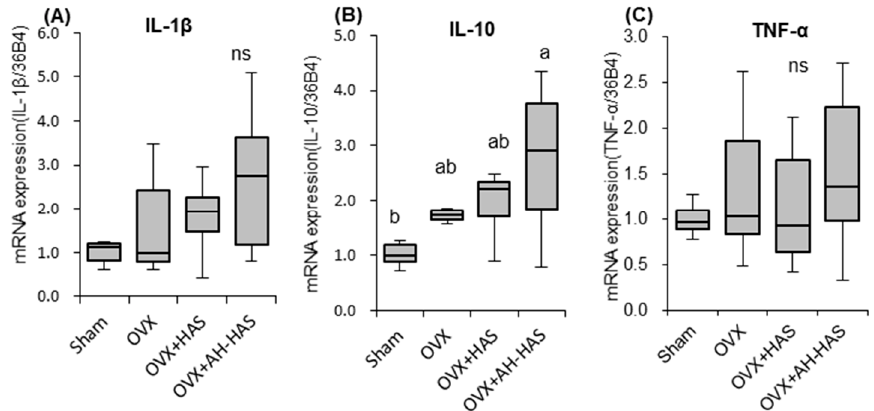
Figure 2. mRNA expression of IL-1 β ( A ), IL-10 ( B ) and TNF- α ( C ) in the colons of mice. mRNA of the colon was obtained from sham mice and OVX mice fed a control diet, 20% high-amylose corn starch (HAS)-supplemented diet (OVX + HAS), or an 20% acid-hydrolysed high-amylose corn starch (AH-HAS)-supplemented diet (OVX + AH-HAS) for 42 days. mRNA expression was determined by qRT-PCR. The ordinate axis indicates the relative amount of mRNA compared with that in sham mice. Gene expression was expressed as the fold-change relative to sham mice and normalised with 36B4. Values are the mean ± SEM ( n = 8). mRNA expression in the colon was assessed using one-way analysis of variance (ANOVA). Differences between treatment groups were assessed by Tukey’s post hoc test. Differences were considered significant if p < 0.05. a, b Mean values with unlike letters are significantly different and ns: not-significant.